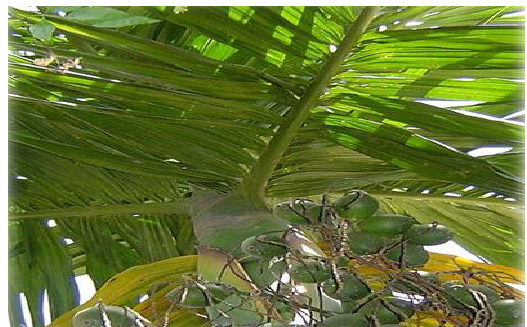
Figure 5. Leaves and fruit of Areca catechu